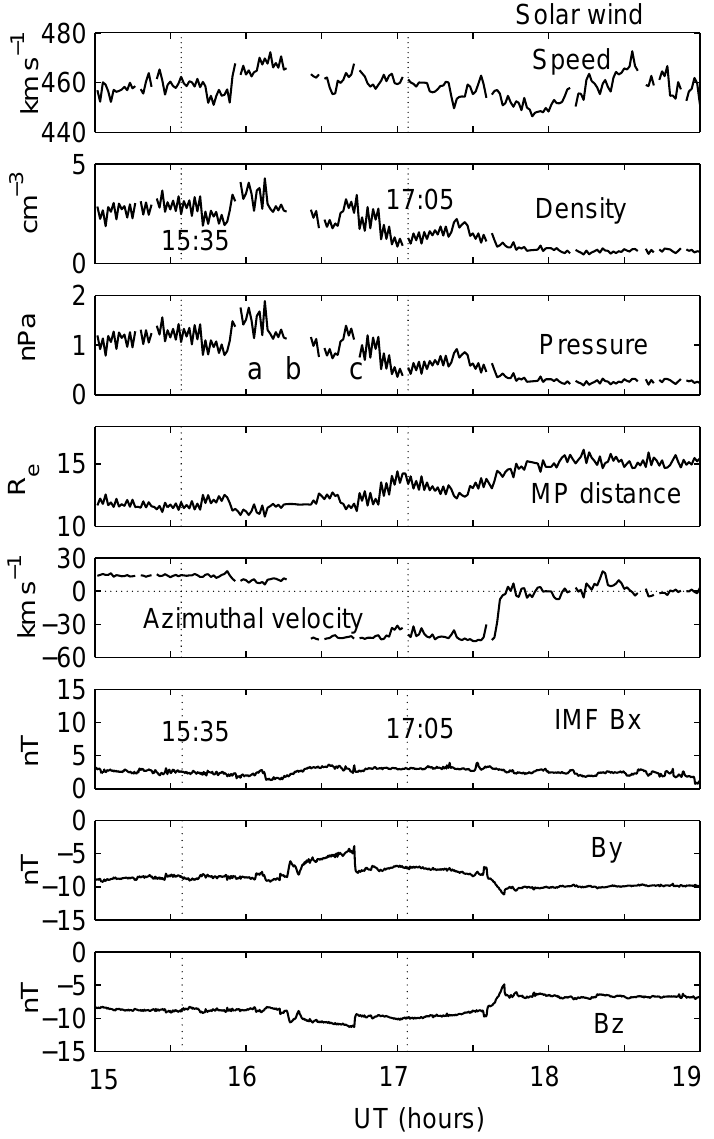
Fig. 2. The solar wind speed, density, dynamic pressure, magnetopause standoff distance and solar wind azimuthal velocity, and IMF B x , B y and B z (in GSM) measured by the ACE satellite during 15:00–19:00 UT on 18 April 2002. The ACE time (15:35- 17:05) corresponding to the Cluster cusp crossing (16:25–17:55 UT) is shown between the vertical